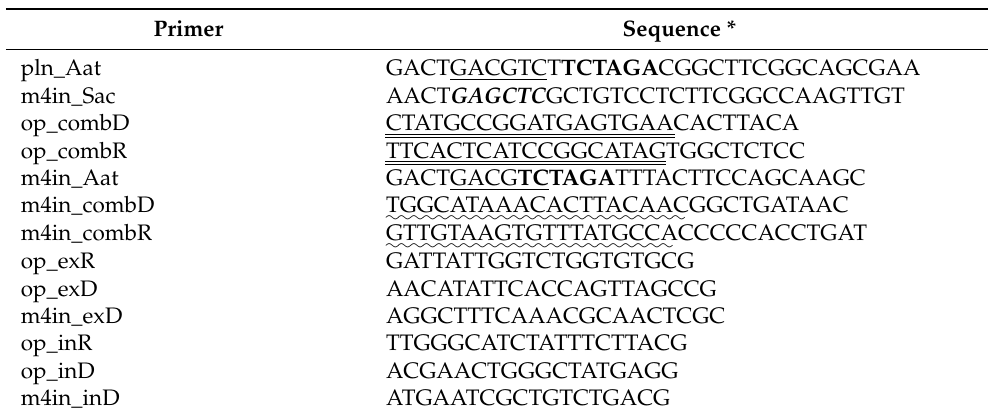
Table 1. Primers